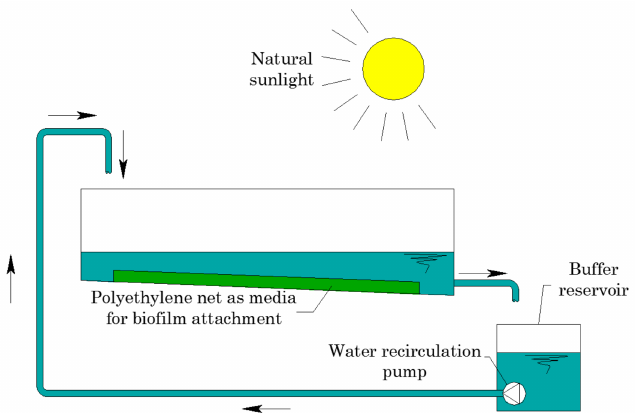
Figure 6. Algae turf scrubber scheme adapted from Shen et al., 2009 and Ting et al., 2017 [39,59].